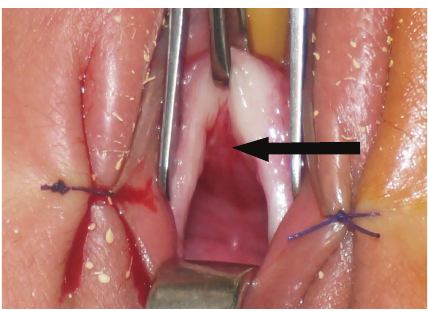
Figure 2: 15min IVU radiography. Bladder filling and vagina opacification.